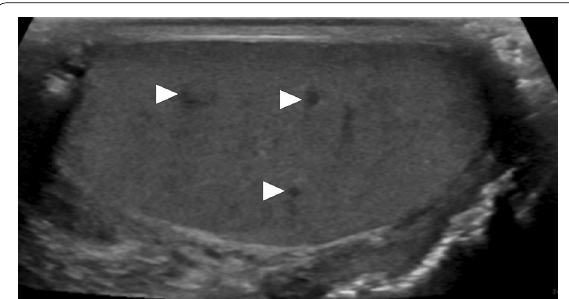
Fig. 14 Testicular sarcoidosis. A 46-year-old male with known sarcoidosis presenting with mild testicular pain. Longitudinal plane gray-scale US image shows several subcentimeter hypoechoic nodules scattered throughout the testis parenchyma (arrowheads). These lesions were presumed to represent testicular involvement of the disease and were found to be stable on follow-up US studies (not